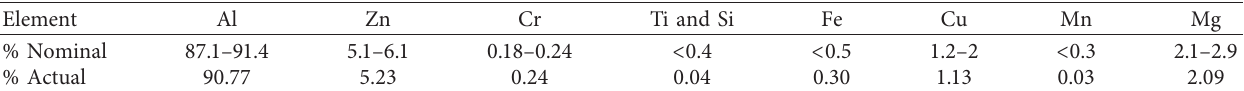
Table 2: Chemical composition of AA